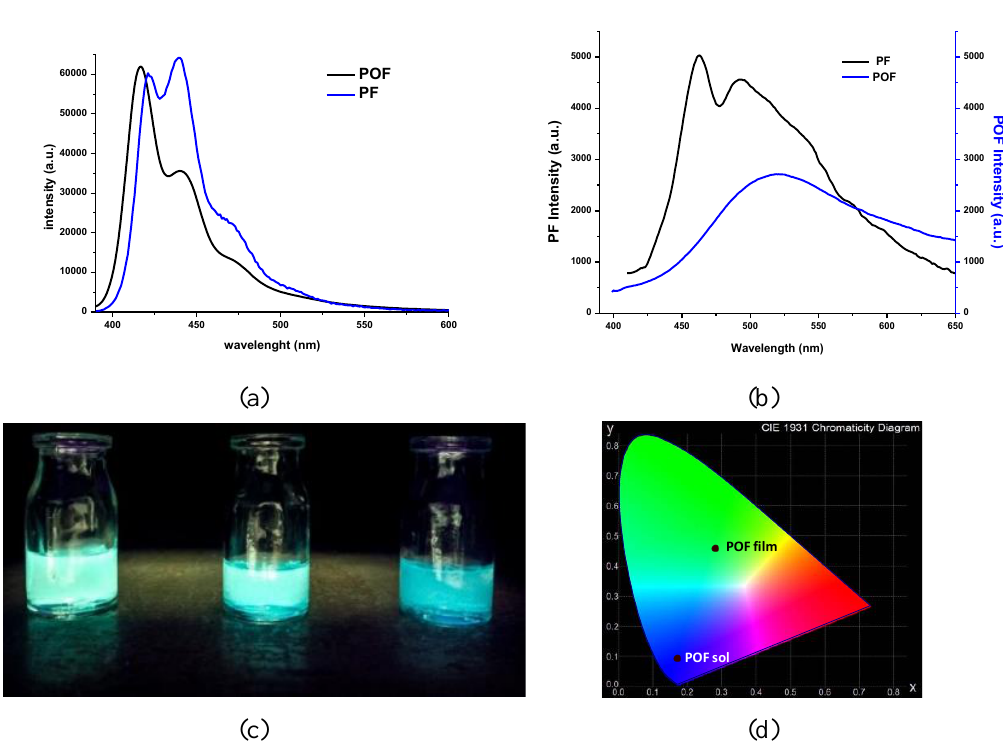
Figure 5. Emission spectra of the poly(fluorene–oxadiazole) and polyfluorene ( a ) in solution and ( b ) film; ( c ) Images of POF solution of 10 −5 , 10 −6 , 10 −7 M (from left to right) under an UV lamp; ( d ) chromaticity diagram.